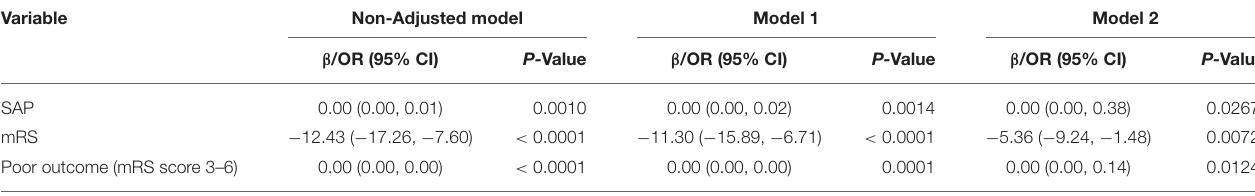
TABLE 2 | Relationship between eosinophils and the SAP/functional outcome among patients with acute ischemic stroke in different models. Variable